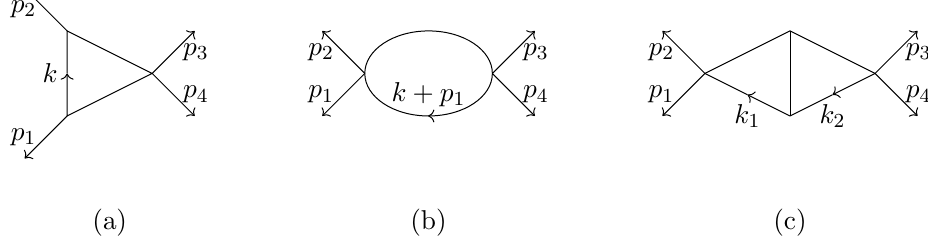
Figure 2 . The integrand of the triangle shown in (a) is an example of a d log form. The integrand of the Feynman integrals shown in (b) and (c) has a (hidden) double pole in four